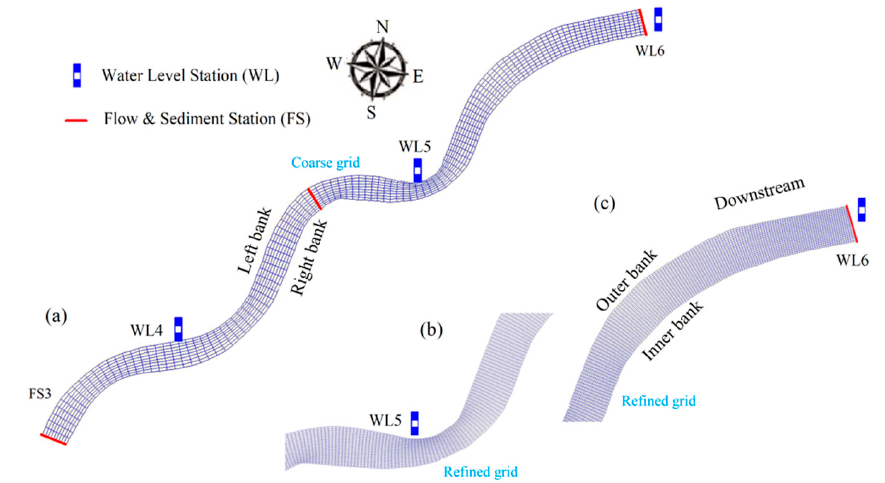
Figure 7. Numerical grids: ( a ) A coarse grid over the domain; ( b ) Local refinement in the vicinity of WL5; ( c ) Local refinement upstream of WL6.